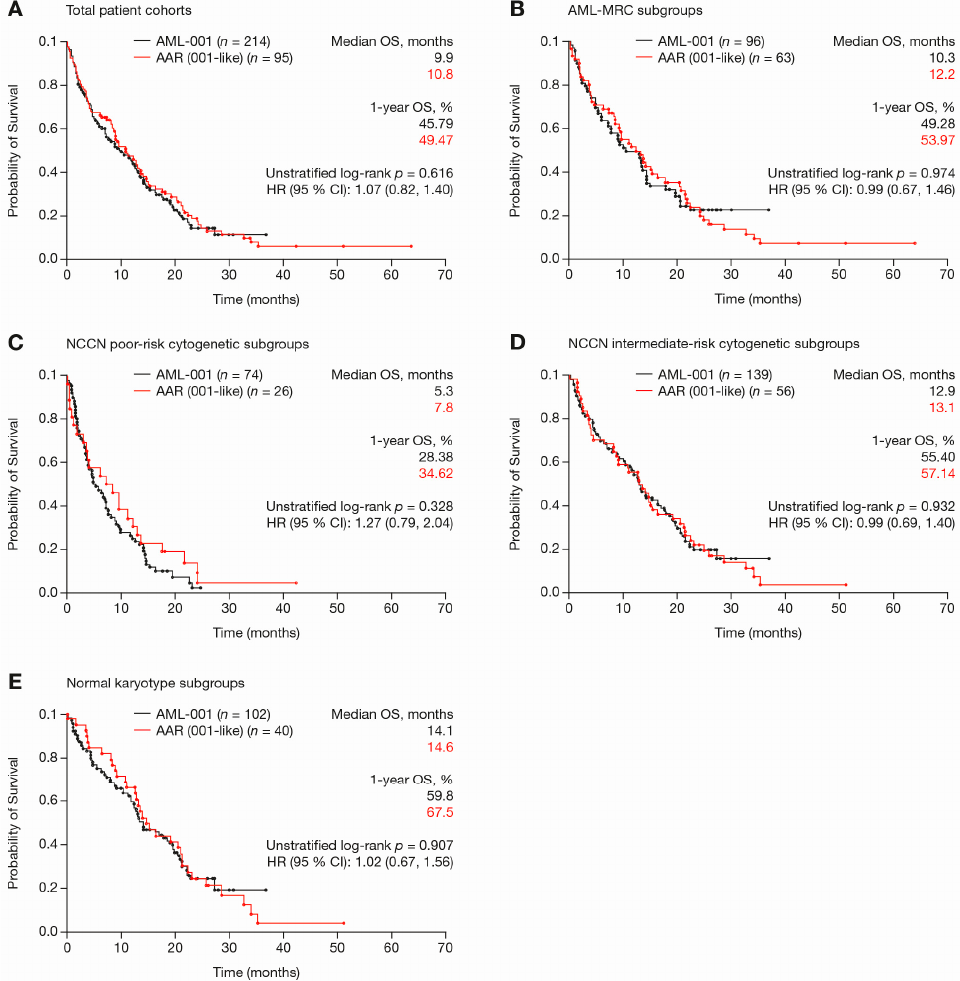
Figure 2. Overall survival (OS) in AML patients with >30% BM blasts and <15 G/L WBC treated with azacitidine front-line within the AML-001 trial and the AAR-AML-001-like cohorts. ( A ) Total patient cohorts; ( B ) AML-MRC; ( C ) AML with NCCN poor-risk cytogenetics; ( D ) AML with NCCN intermediate-risk cytogenetics; and ( E ) Normal karyotype.